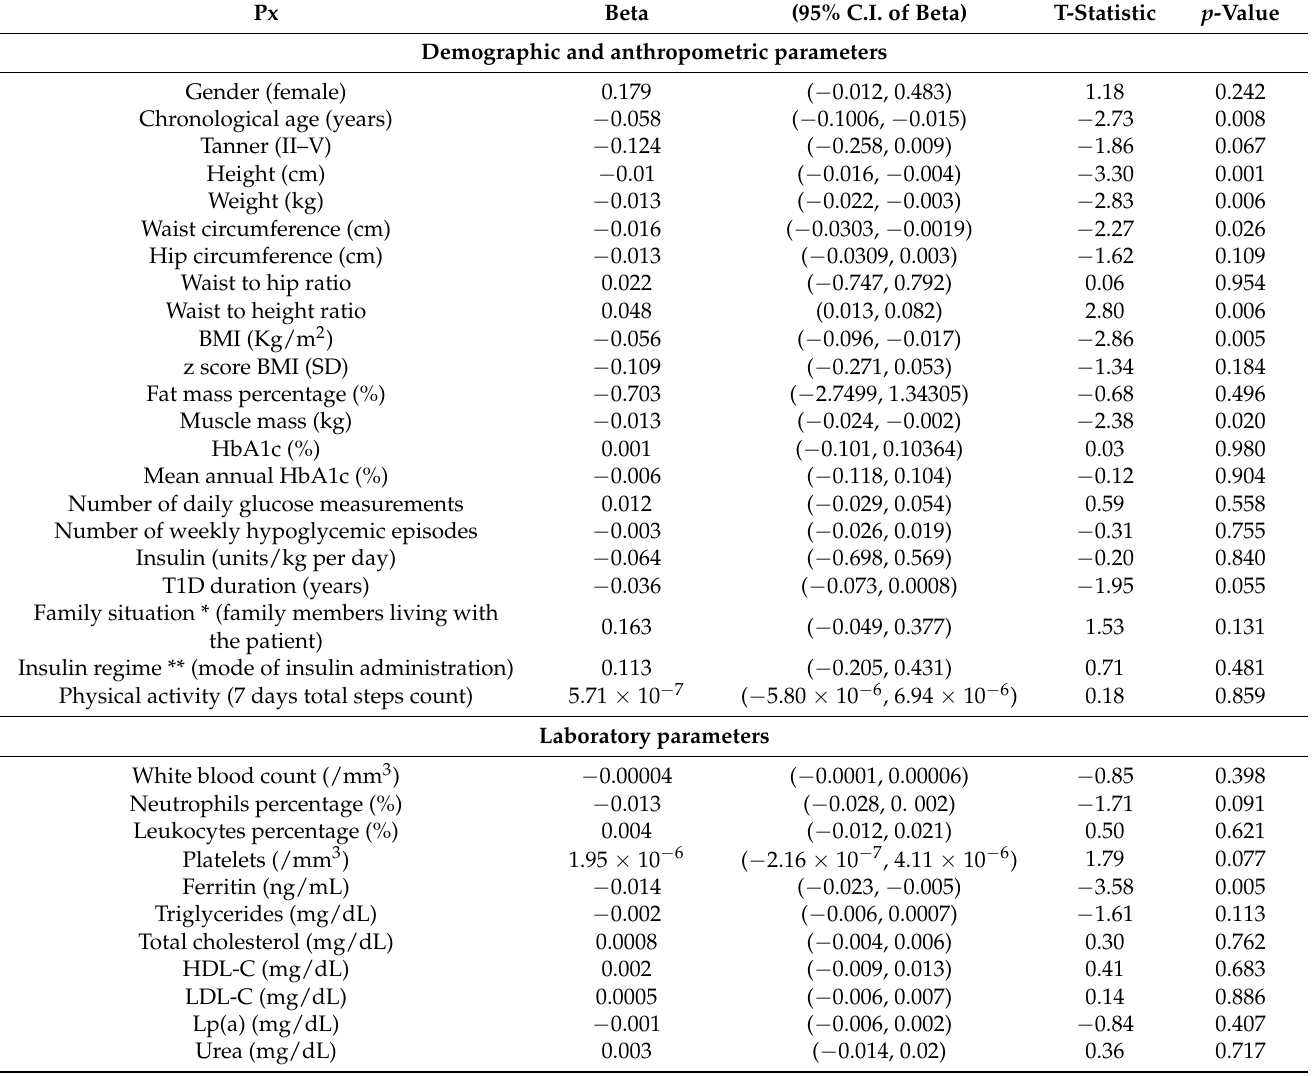
Table 4. Adiponectin correlations with basic demographic and physical and biochemical parameters with the use of univariant linear